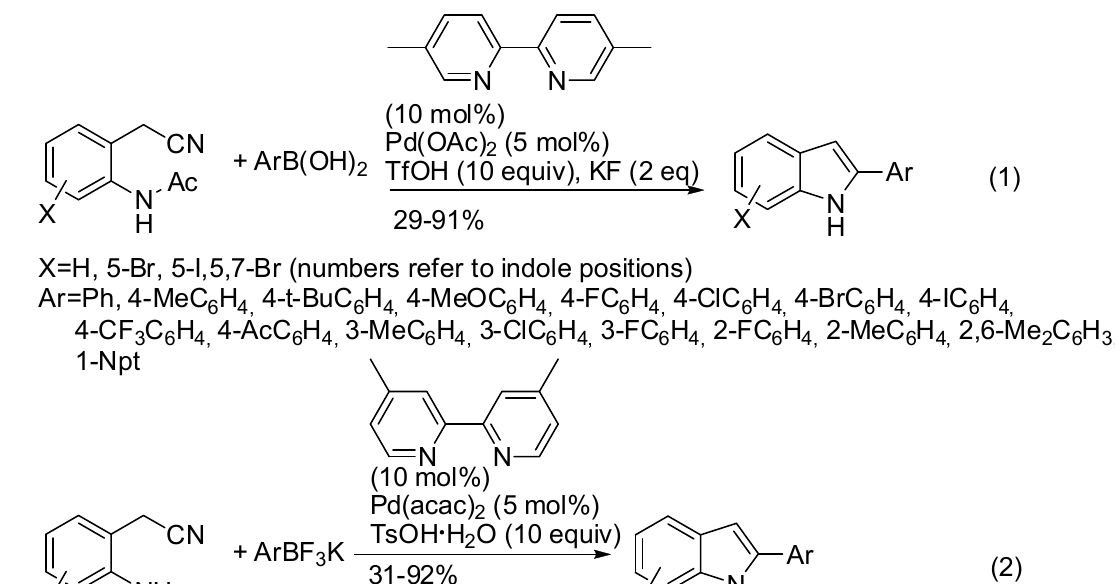
(2 equiv) R = C 10 H 21 ,